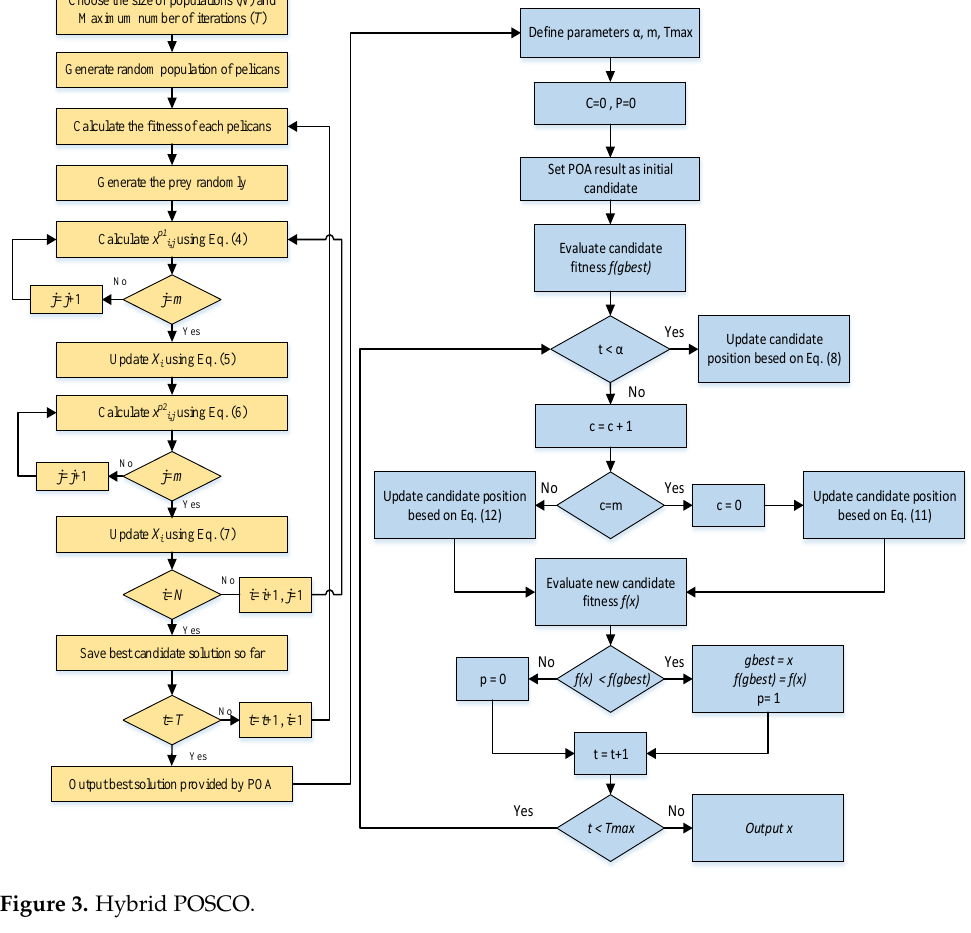
Figure 3. Hybrid